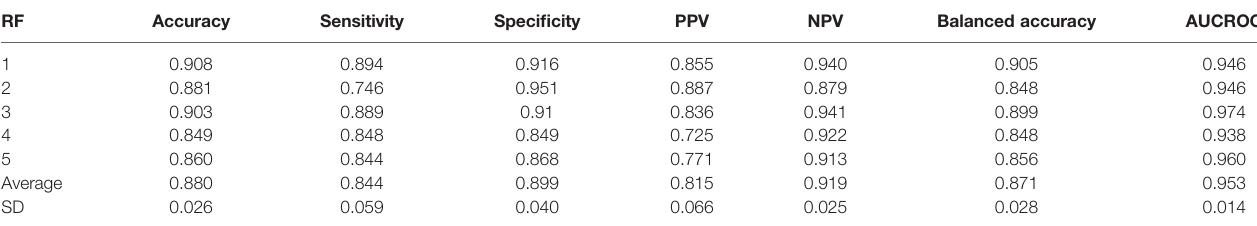
TABLE 1 | Five-fold cross validation for the random forest method with 10 variables.